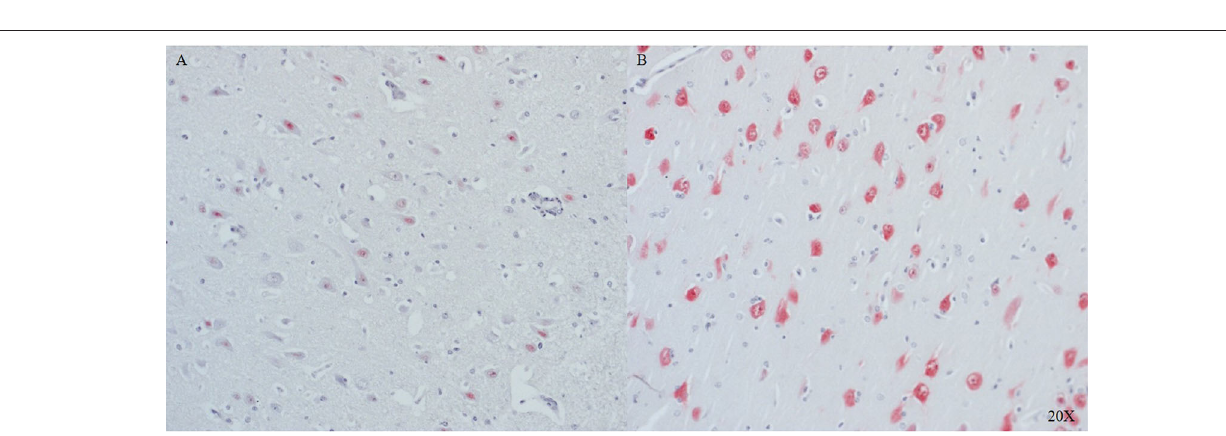
FIGURE 4 | NeuN expression in cortical neurons of the frontal cortex close to (A) and further away (B) from the injury site ( n = 6). Cortical neurons show little to no expression of NeuN in proximity to the injury (A) , in distance to the injury cortical neurons show NeuN expression (B) . NeuN, neuronal nuclei.